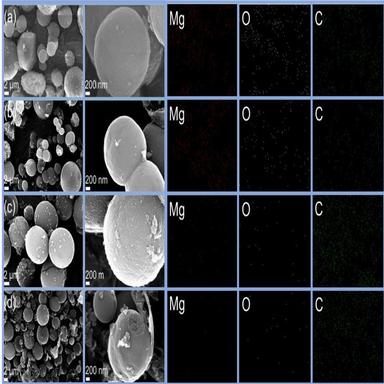
SEM and mapping images of (a) Mg-BTC, (b) MgO/C, (c) SPC and (d) SAPC.